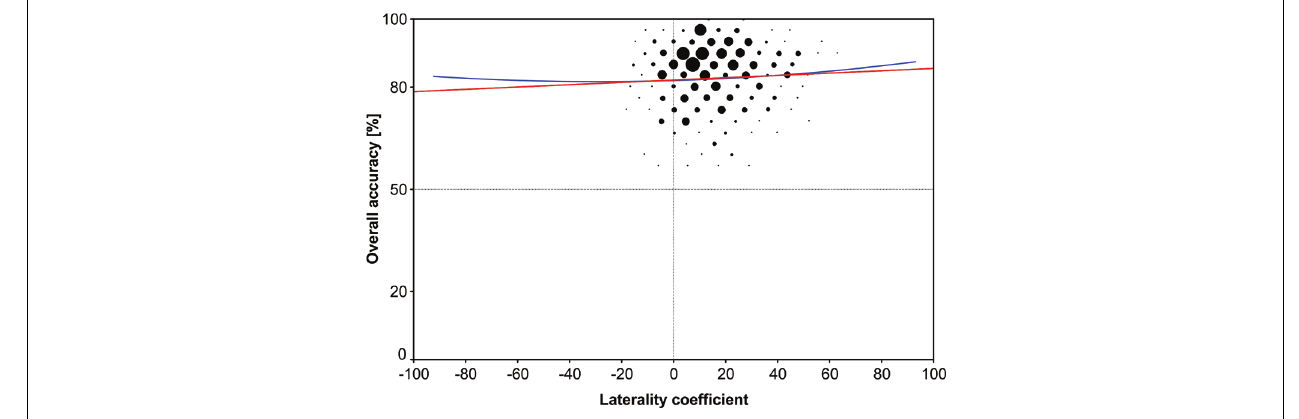
FIGURE 3 | Results of the traditional approach. The bubble chart shows the linear (red line) and quadratic regression (blue line) between overall accuracy and degree of lateralization.